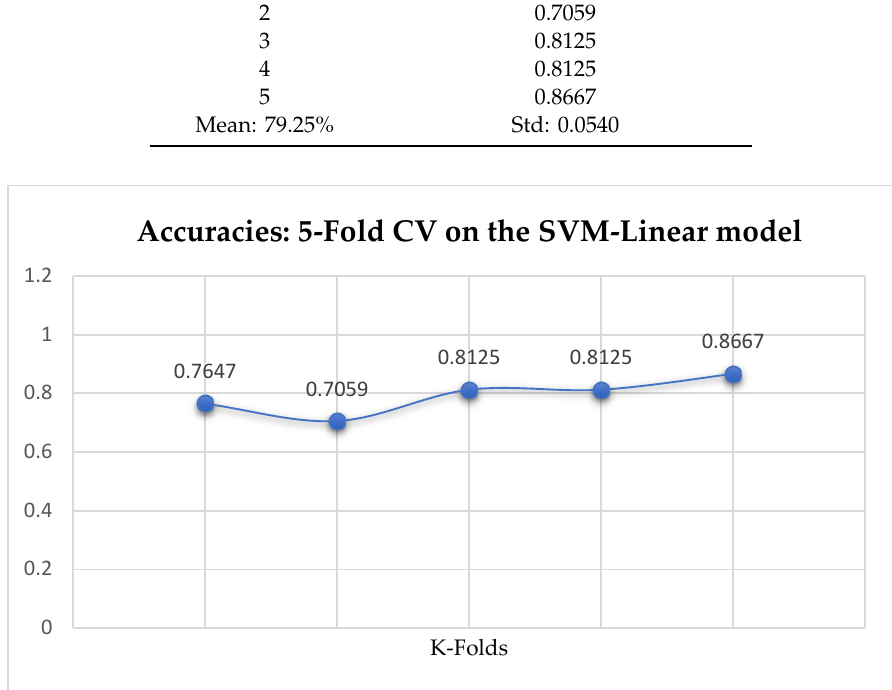
Figure 21. The accuracies achieved by the Folds after performing 5-Fold Cross-Validation on the Support Vector Machines (SVM)-Linear model.